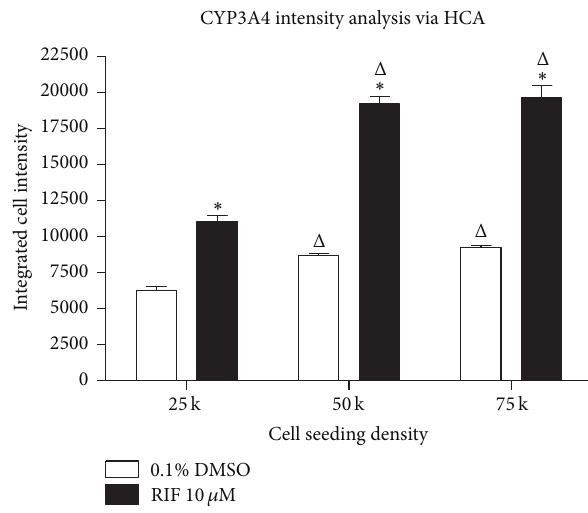
Figure 8: Quantification of CYP3A4 expression changes via HCA. Using quantitative HCA image analysis, the cellular intensity of CYP3A4 staining in small nuclei HepaRG cells treated with vehicle or 10 𝜇 M rifampicin at each cell seeding density was determined. Data represent mean ± SEM for 3 independent experiments. ∗ represents 𝑃 < 0.05 versus DMSO vehicle controls at the same cell seeding density; Δ represents 𝑃 < 0.05 versus HepaRG cells seeded at 25,000 cells per